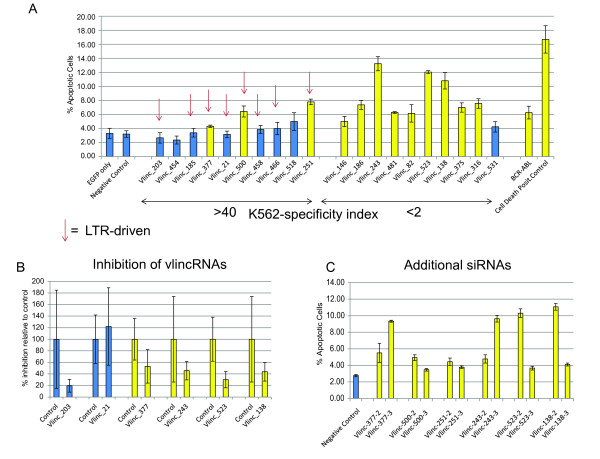
Results of vlincRNA RNAi inhibition study. Percent of apoptotic GFP-positive cells (Y-axis) is shown for each indicated treatment (X-axis) for original set of 20 vlincRNAs with 1 siRNA per vlincRNA (A) and for the validation set where 2 additional independent siRNAs per vlincRNA were designed (C). Depletion of selected vlincRNAs was confirmed using real-time RT-PCR (B). "EGFP only" is transfection with EGFP-expressing plasmid only, all other designations imply co-transfection of EGFP-expressing plasmid with the indicated siRNA. Treatments highlighted in yellow are significant at p-value of < 0.05 (Student one-sided t-test). Error bars show standard deviations of 3 independent transfections (A, C) or RT-PCR reaction (B). Results from the negative control siRNA, positive control siRNA against BCR-ABL and AllStars Hs Cell Death positive control siRNA blend are also shown. The vlincRNA data is sorted by the K562-specificity index (see text) with the most K562-specific vlincRNAs on the left (A). Additional details in text and Materials and Methods. The original data is shown in Additional File 3, Table S3.